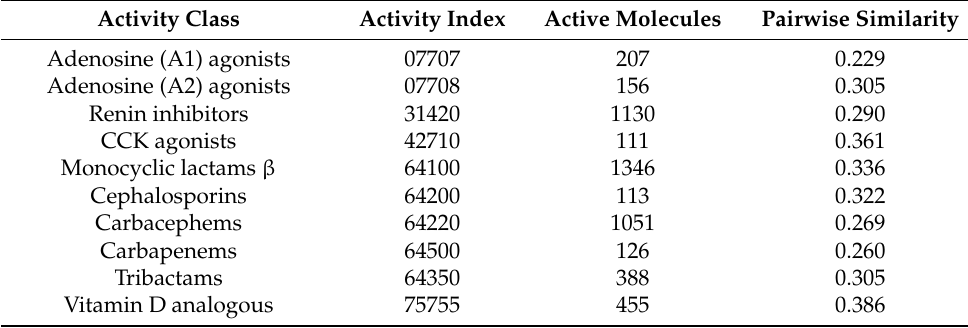
Table 2. The MDDR-DS2 (structurally homogeneous) activity classes.